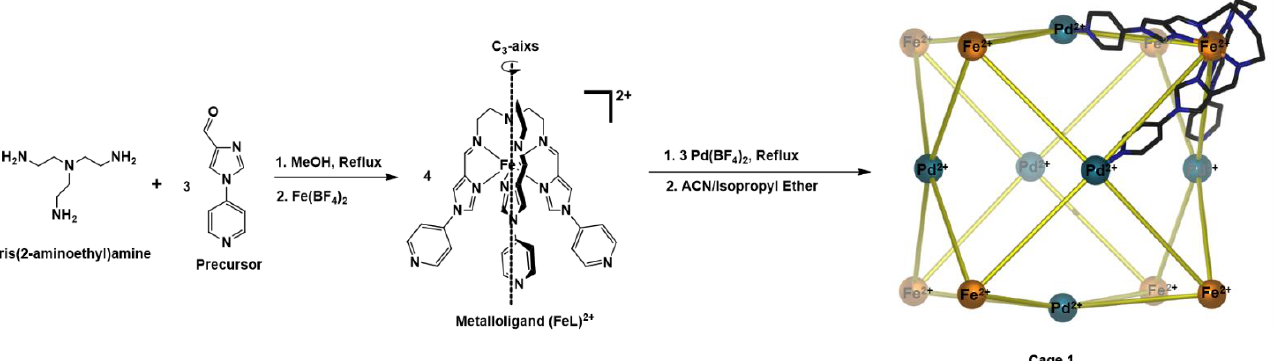
Scheme 1. Synthesis of cubic cage 1 using the metalloligand approach.